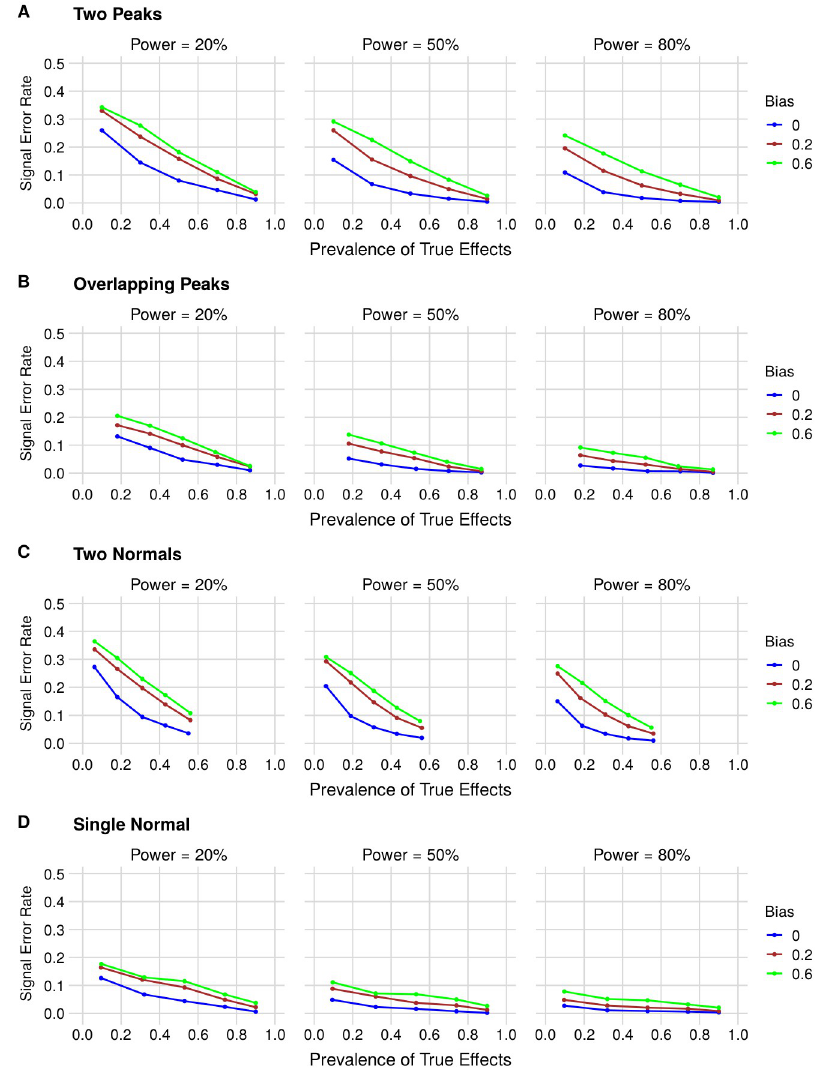
Fig 3. Type S error rate (i.e. published estimates with the wrong sign) as a function of the prevalence of true effects, statistical power and bias for (A) Two Peaks, (B) Overlapping Peaks, (C) Two Normals and (D) Single Normal effect size distributions. The rate corresponds to the percent of published (i.e. statistically significant) estimates that are in the opposite direction of the true effect. Each point corresponds to the sign error rate from a simulation with 5,000 published findings. In each panel, graphs correspond to 20%, 50% and 80% power from left to right. Blue, red and green curves correspond to bias of 0, 0.2 and 0.6, respectively. Prevalence ranges vary among scenarios, as for some distributions some prevalences cannot be achieved without changing other